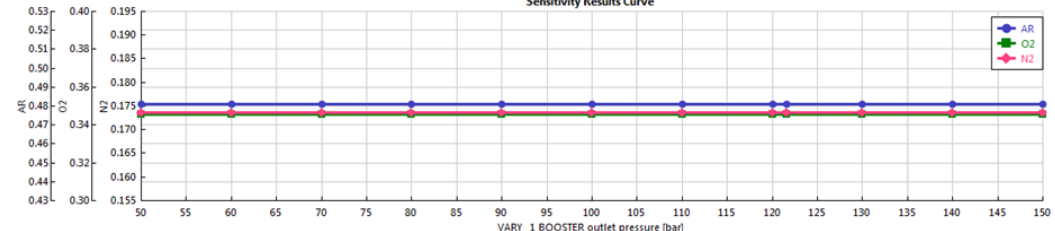
Figure 7. ARO2RECT molar fractions vs. BOOSTER discharge pressure.